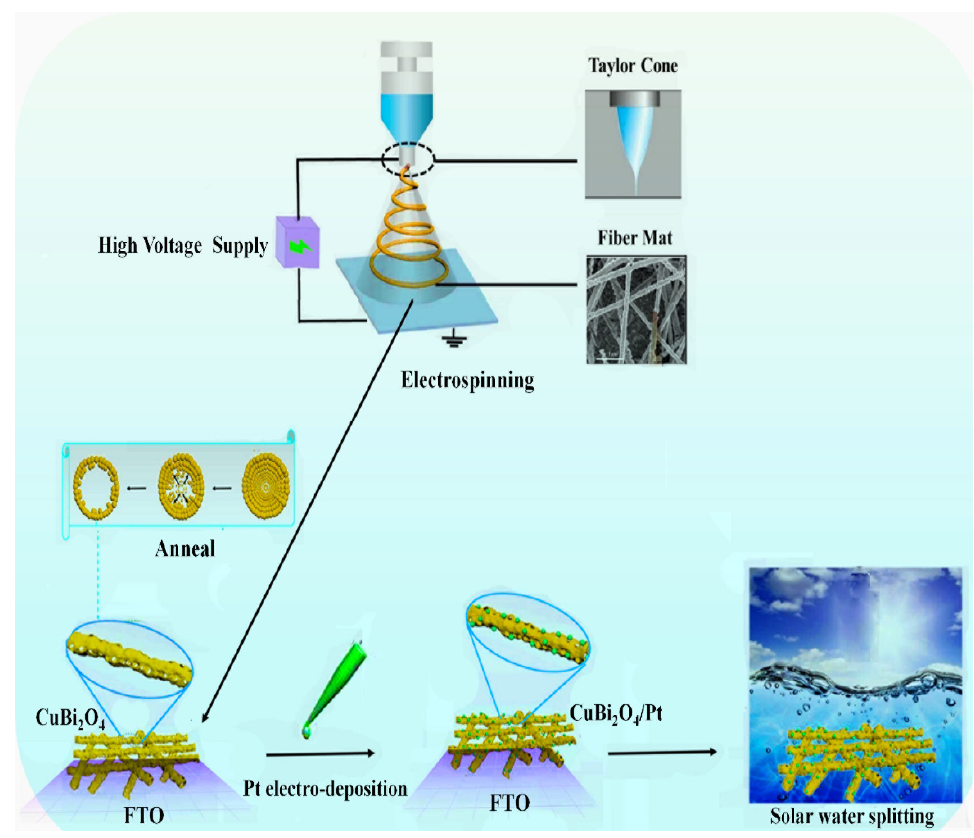
Figure 1. Schematic illustration of the CuBi 2 O 4 /Pt nanofiber fabrication process.